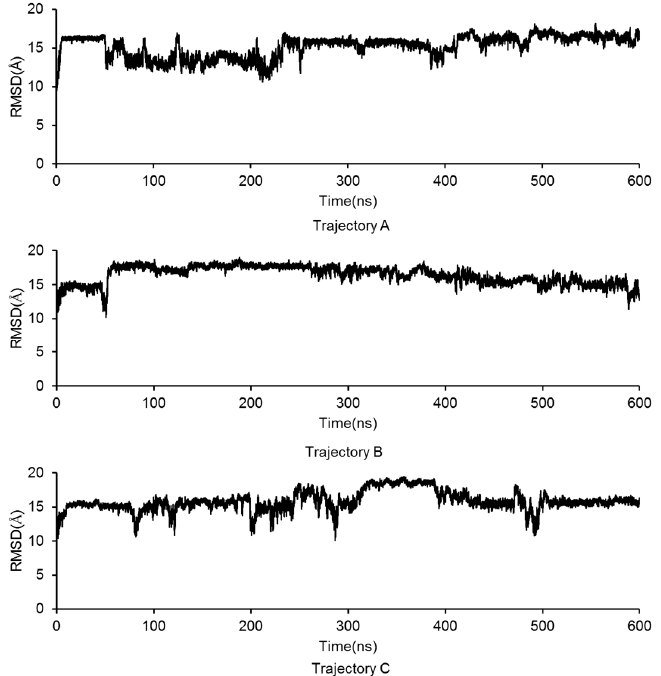
Figure 3. The GluN2B-CT 1290-1310 all-atoms RMSD values along the 600 ns MD simulations for the repeated trajectories A , B , and C .